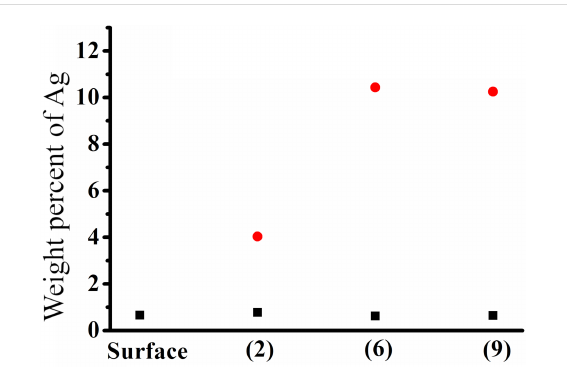
Table 3: The elemental content of the pile-ups of the cavities for the hierarchical SERS substrate with a machining feed of f x = 2 μ m and f y = 2 μ m.